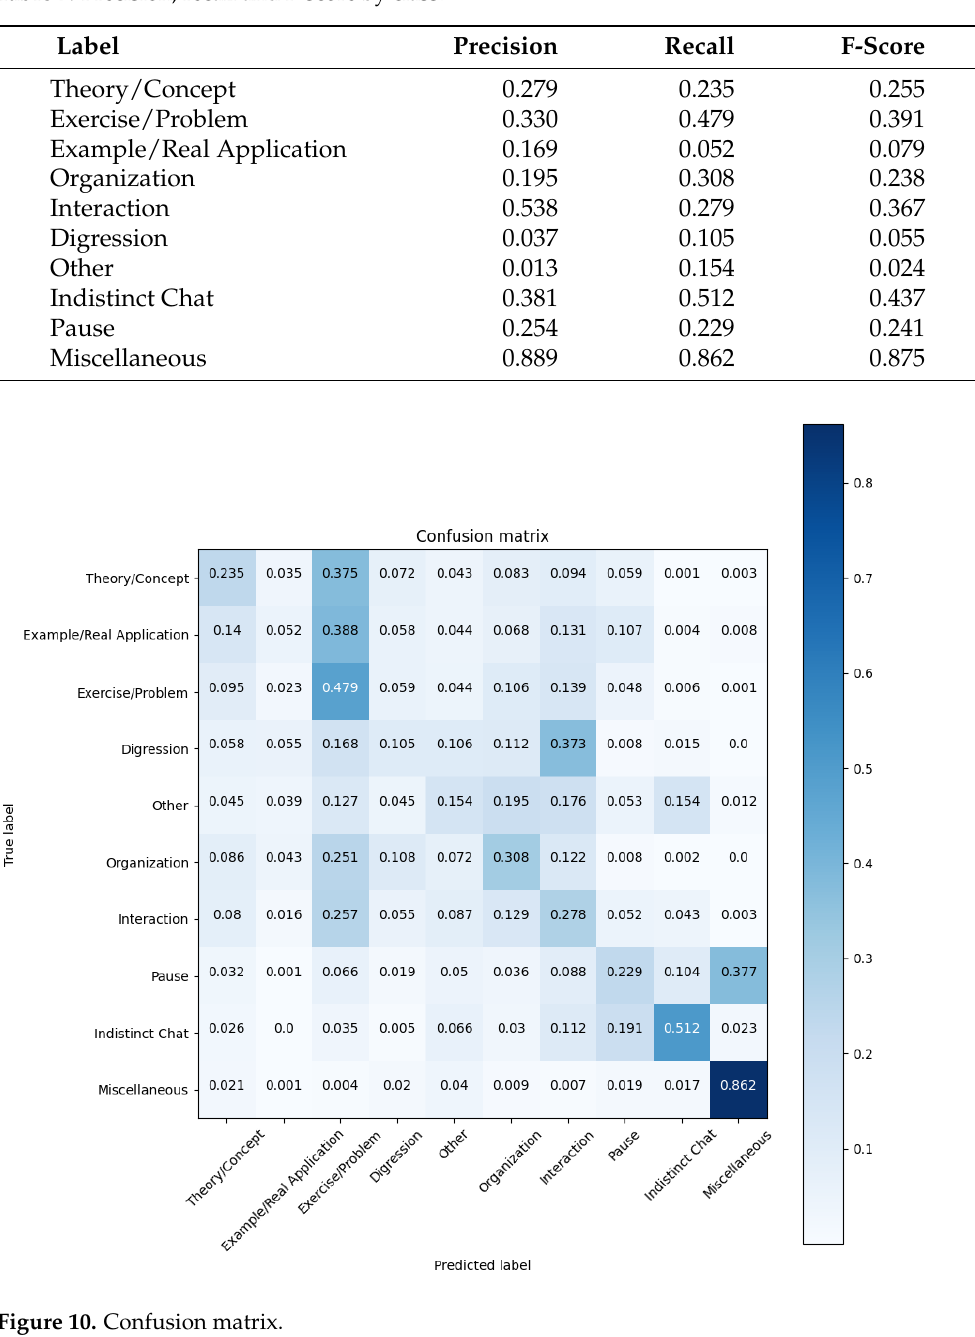
Table 7. Precision, recall and F-score by class.